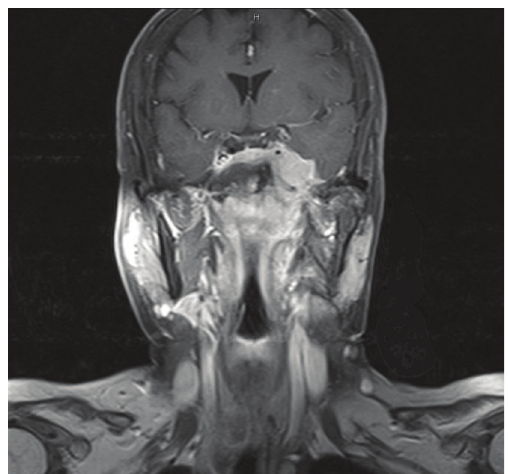
Figure 1: A representative case of ascending-type NPC. Coronal spin echo-enhanced T1-weighted MR image shows nasopharyngeal tumor with upward invasion into left cavernous sinus and medial temporal lobe. Small subclinical lymph nodes are noted at left